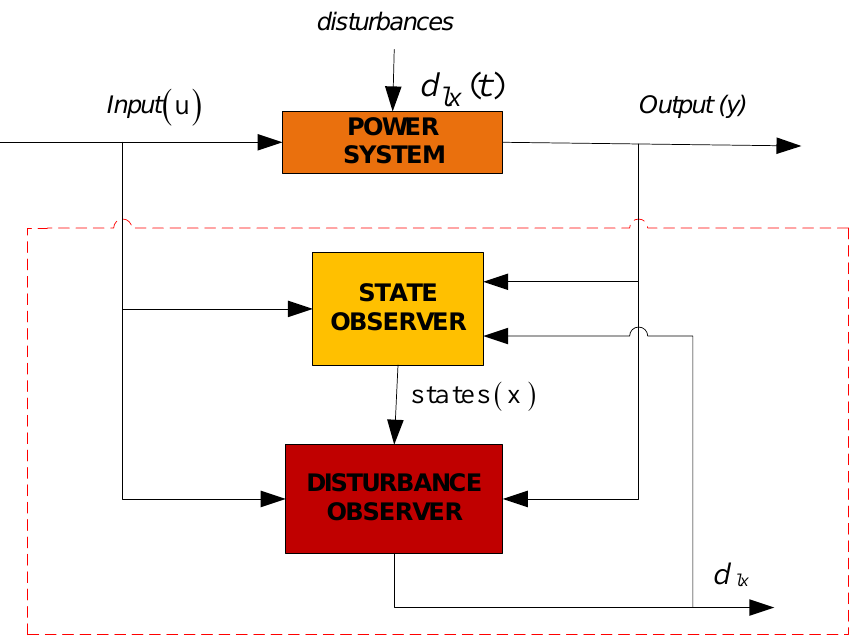
Figure 2. Set up for disturbance